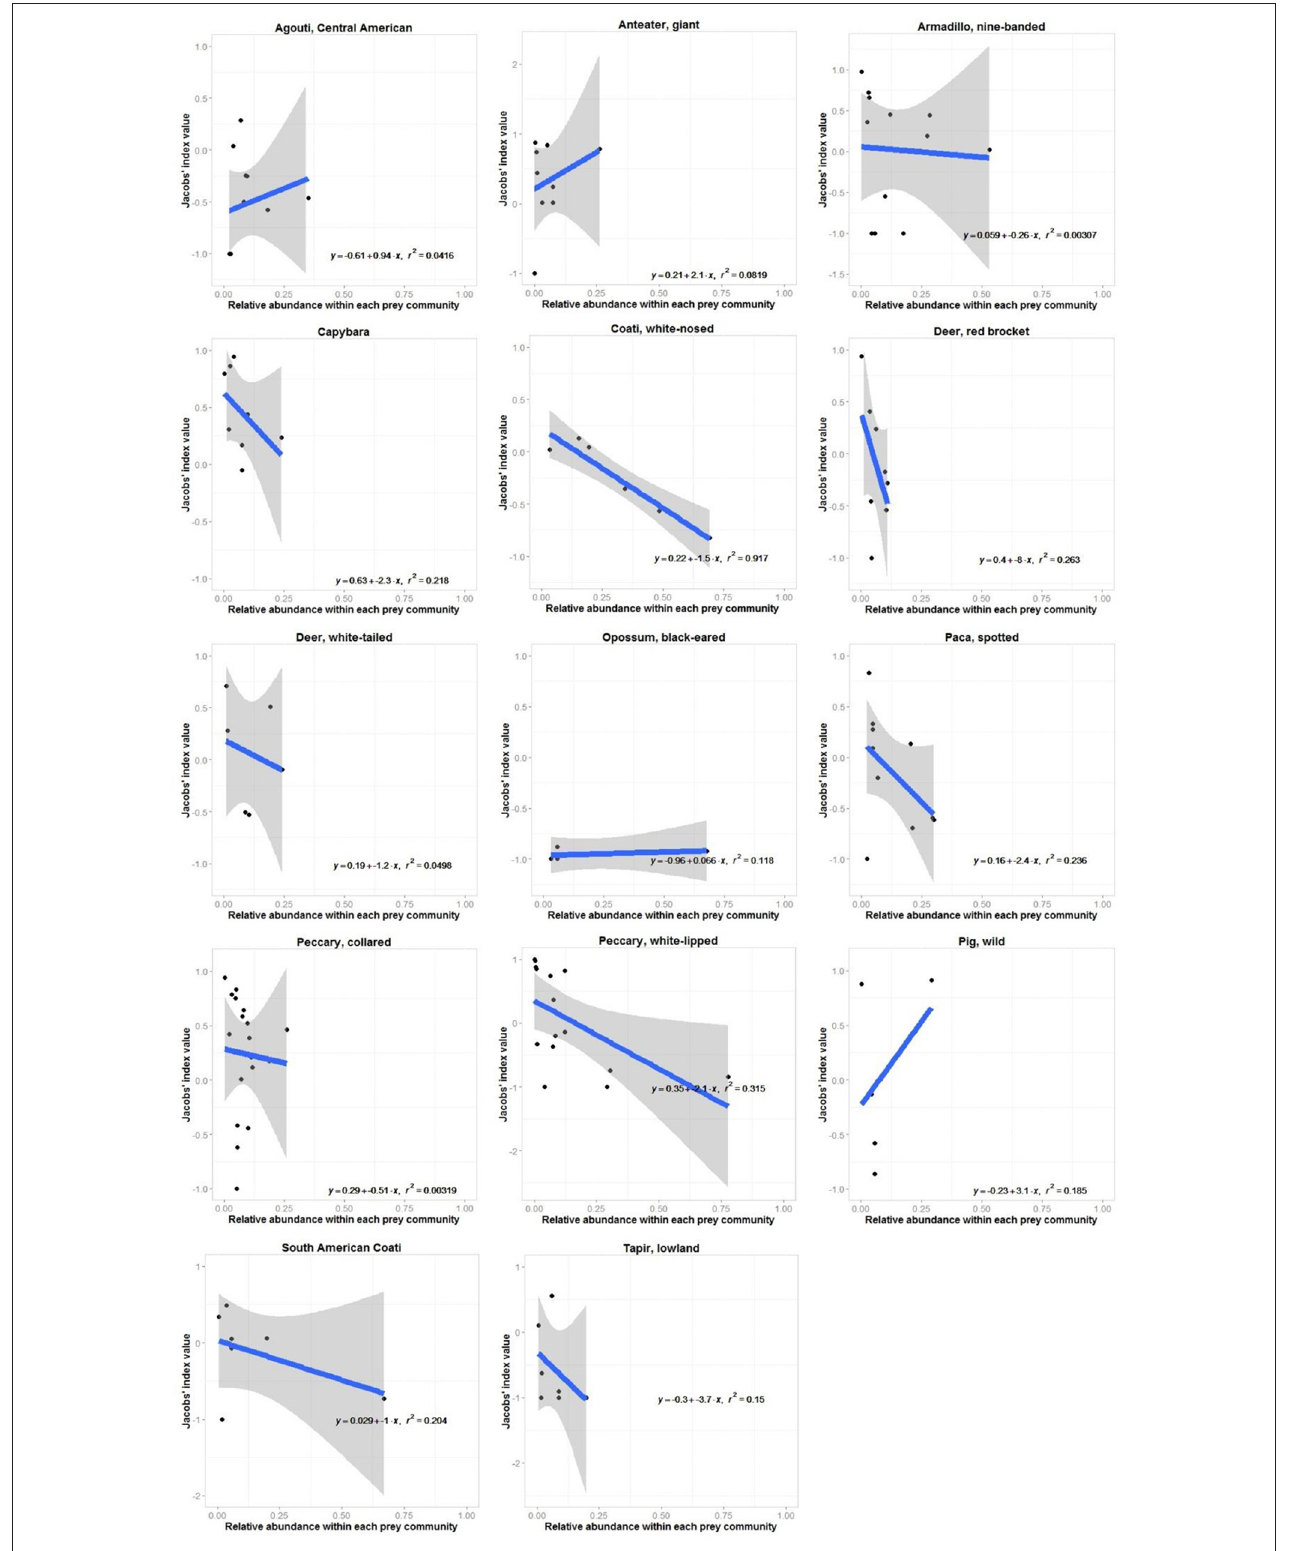
FIGURE 3 | Relationship between site-specific preference (Jacobs’ index value) and relative abundance for each prey species of jaguars with four or more Jacobs’ index value estimates within the prey community. Ninety-five percent confidence intervals are shown unless they extend to far beyond the y-axis